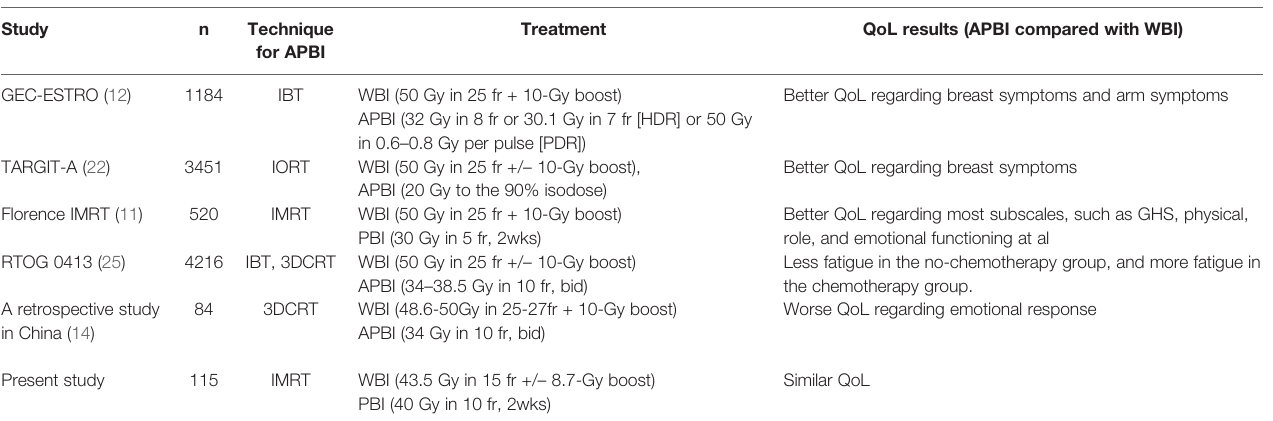
TABLE 5 | Summary of QoL comparisons between APBI and